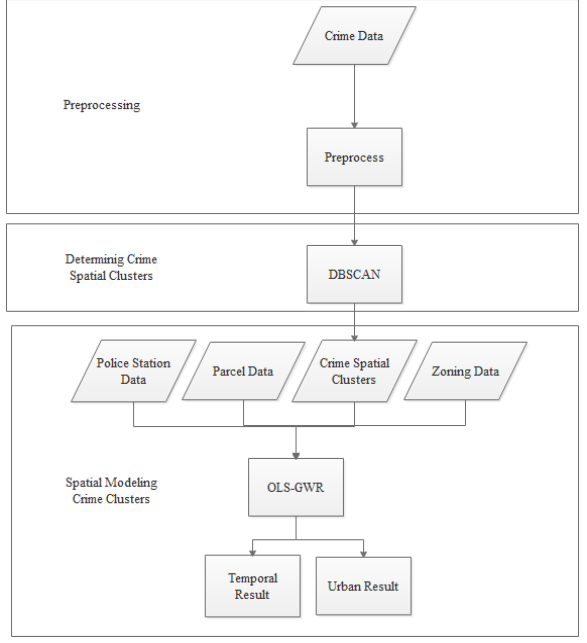
Figure 1. The workflow of spatial modeling for crime